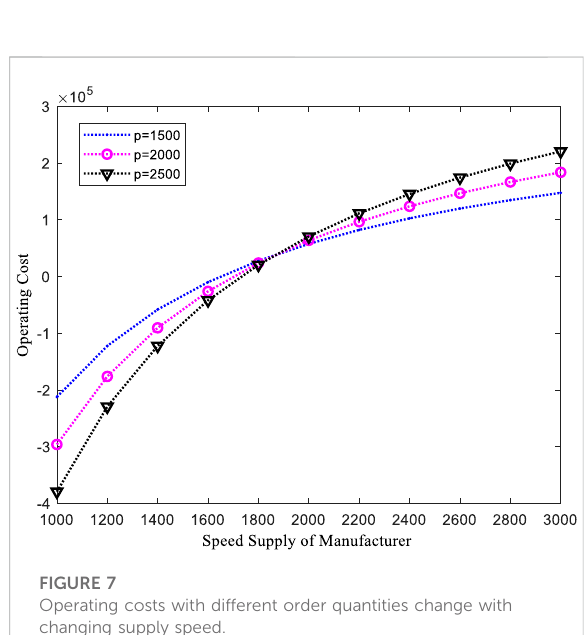
FIGURE 7 Operating costs with different order quantities change with changing supply